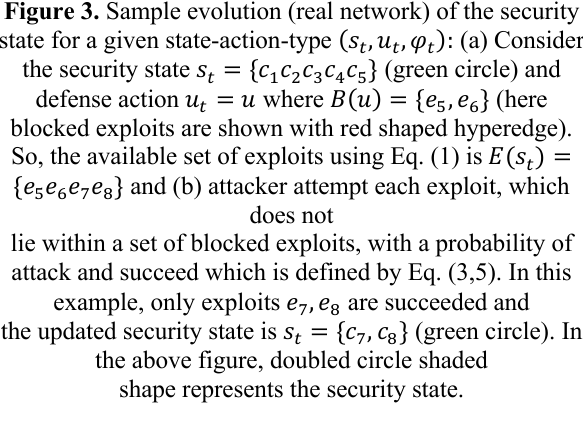
): (a) Consider , 𝑢 , 𝜑 F F F = {𝑐 𝑐 𝑐 𝑐 𝑐 } (green circle) and F , - a i j = 𝑢 where 𝐵(𝑢) = {𝑒 , 𝑒 } (here F j l